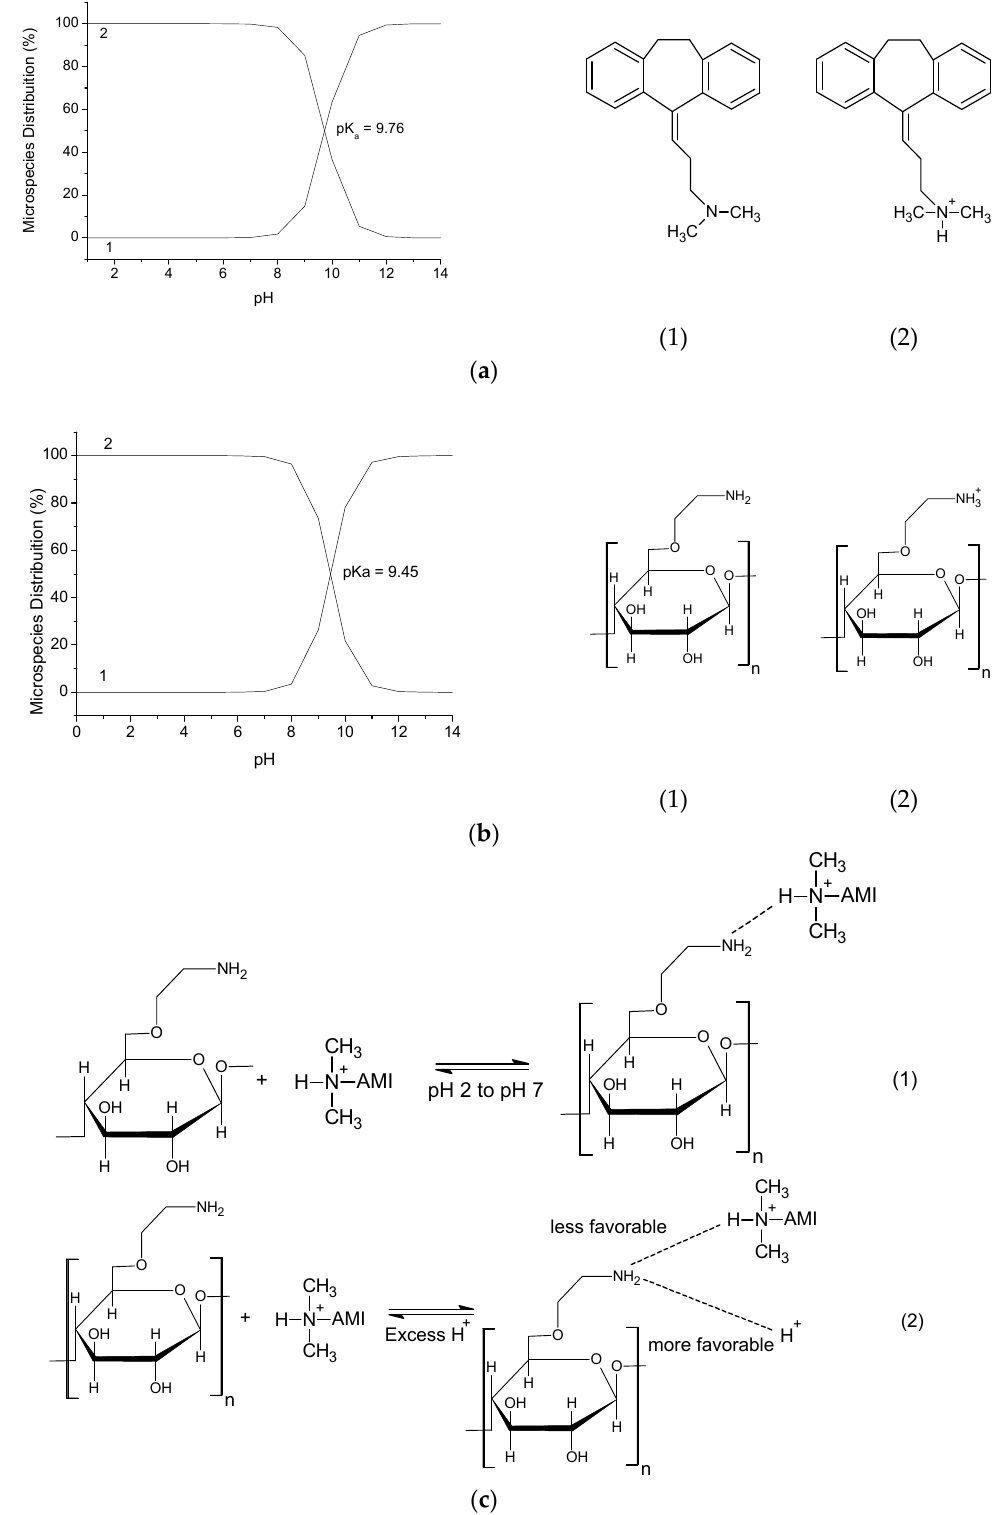
Figure 8. ( a ) Distribution of AMI microspecies at different pH values; ( b ) distribution of CN polymer microspecies at different pH values; ( c ) adsorption mechanism proposal of AMI adsorption by CN polymer.